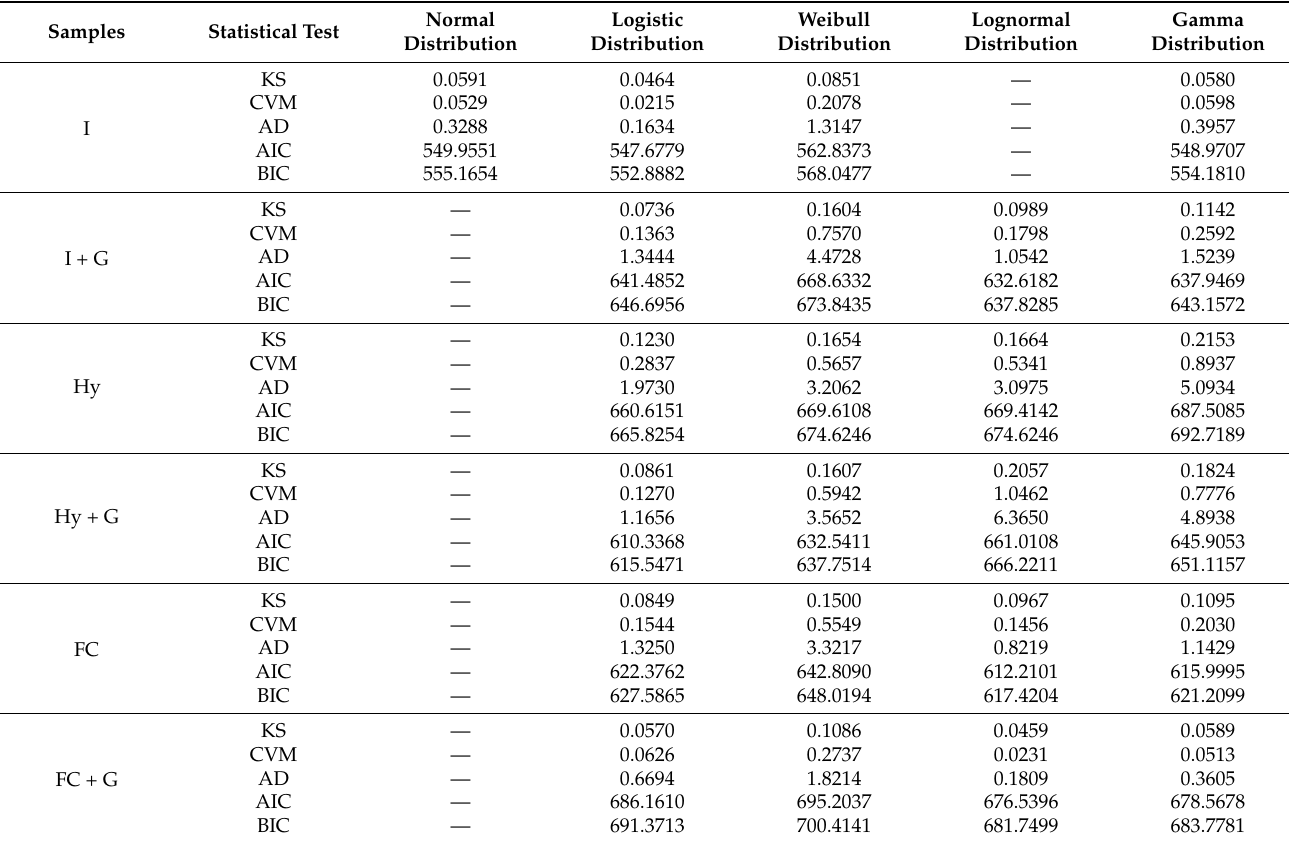
Table A1. Goodness-of-fit statistics are illustrated for (I) initial state, (I + G) initial state and graphene, (Hy) hydrophilic agent, (Hy + G) hydrophilic agent and graphene, (FC) functional coating, and (FC + G) functional coating and graphene. Kolmogorov–Smirnov (KS), Cramer–von Mises (CVM), Andersen–Darling (AD) statistics and Akaikes’s (AIC) and Bayesian’s (BIC) Information Criterions were